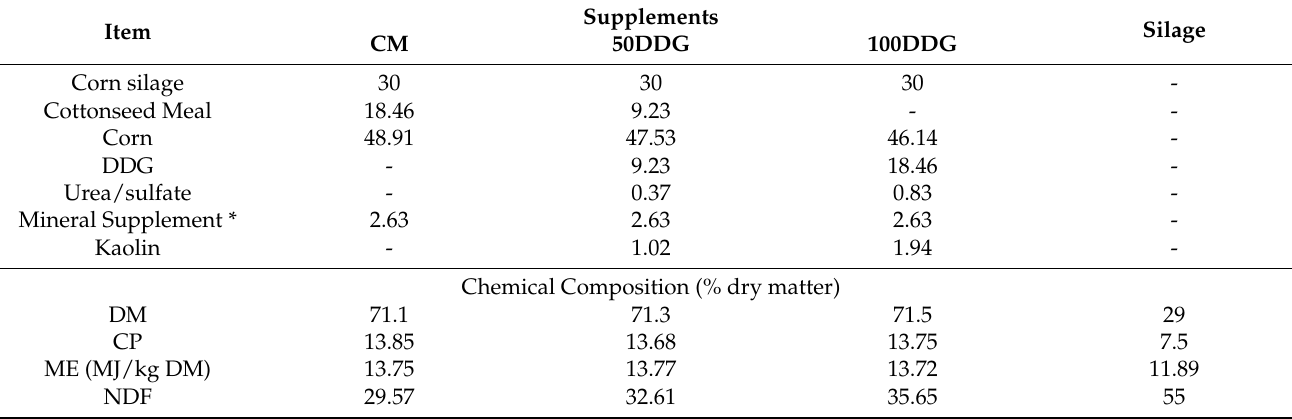
Table 2. Percentage of inclusion and chemical composition of supplements and silage in the feedlot